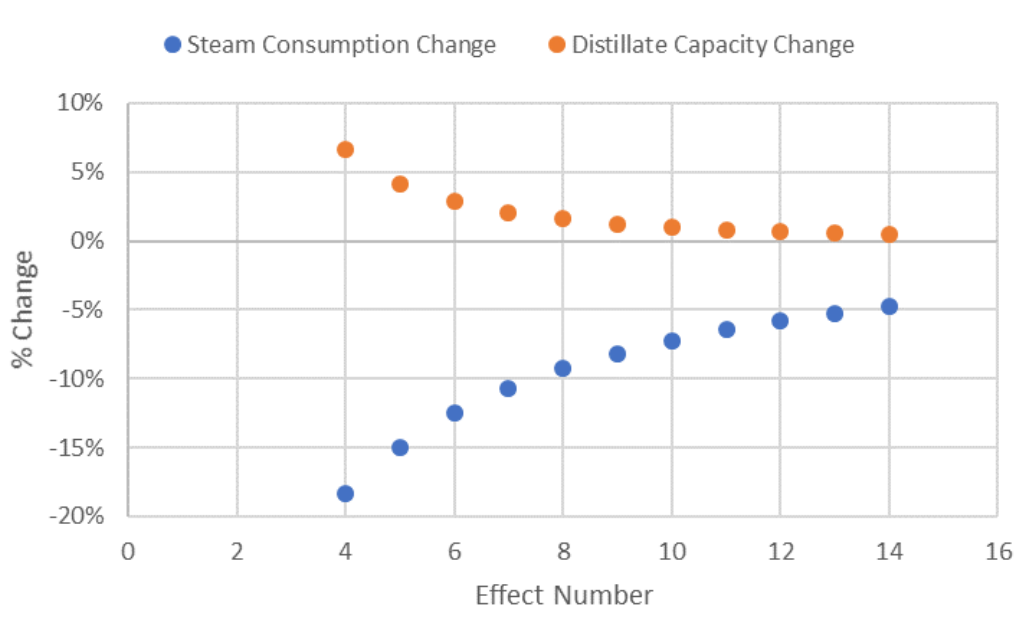
Figure 4. Net change in distillate production and steam consumption with e increase in number of evaporation effects.